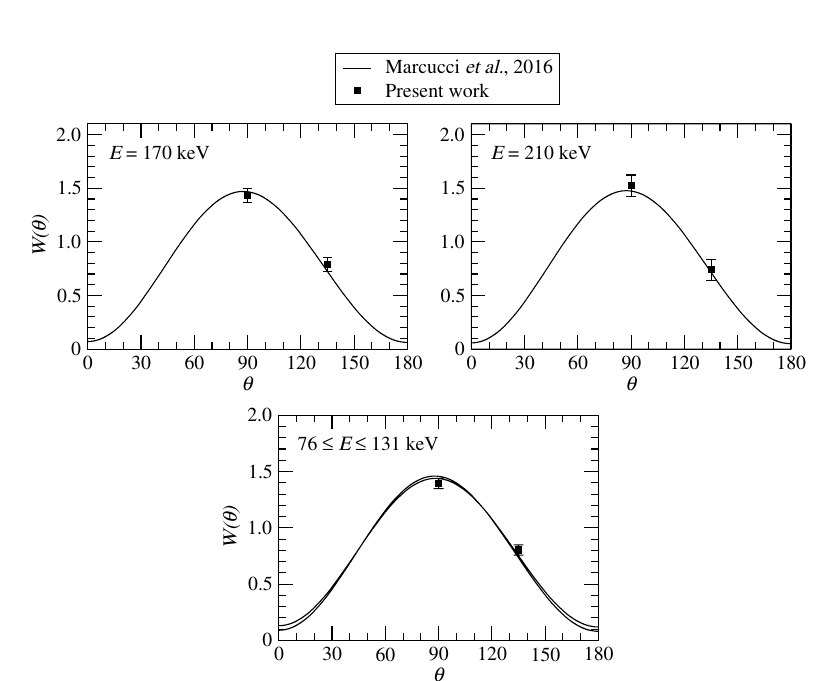
Figure 2. Angular distribution of the 2 H(p, γ ) 3 He reaction. The experimental data were obtained at θ = 90 ◦ and 135 ◦ .